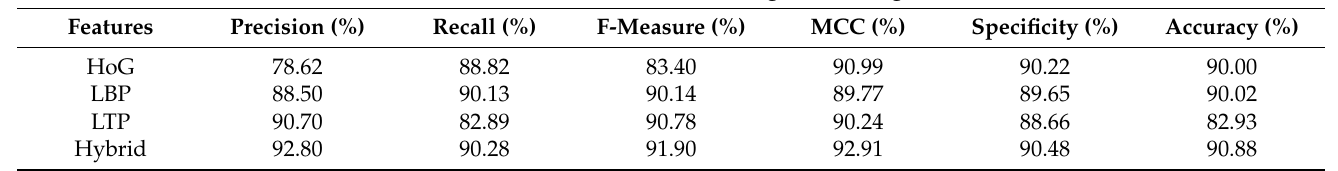
Table 5. Simulation results of the proposed model by varying the features with 50:50% training and testing of data.